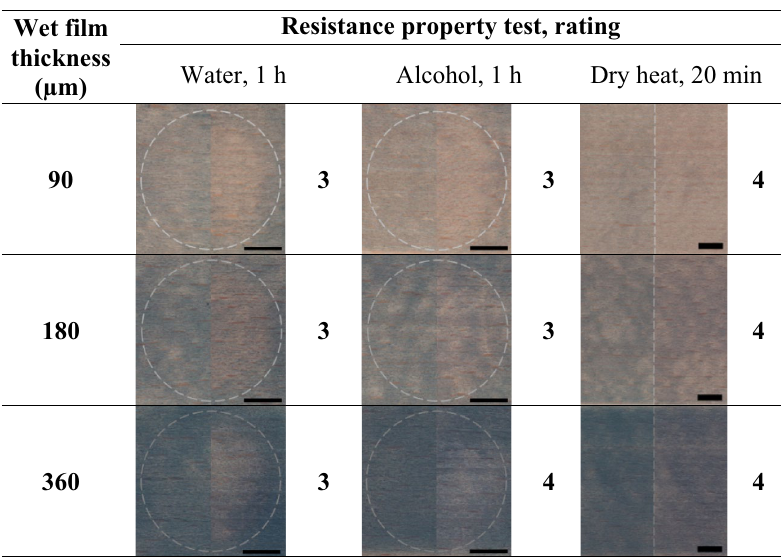
Table 2. The results of the resistance properties. The length of the scale bars is 10